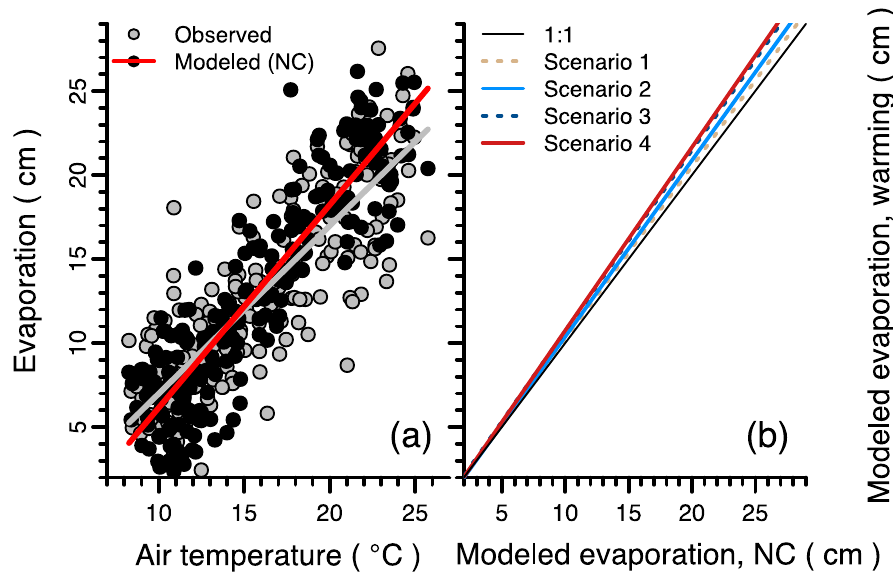
Figure 6. ( a ) Relationship between mean monthly mean air temperature and mean monthly evaporation for 1992 to 2011. The equation for observed evaporation ( E OBS = − 3.01 + 1.00 × T A ) gives an Adj. R 2 = 0.73 ( p < 0.001) and the equation for modeled (NC; reference run with no change) evaporation ( E MOD = − 5.93 + 1.21 × T A ) gives an Adj. R 2 = 0.81 ( p < 0.001). ( b ) Relationship between evaporation in reference run (NC; x-axis) vs. warming scenarios (y-axis). Evaporation increased for all